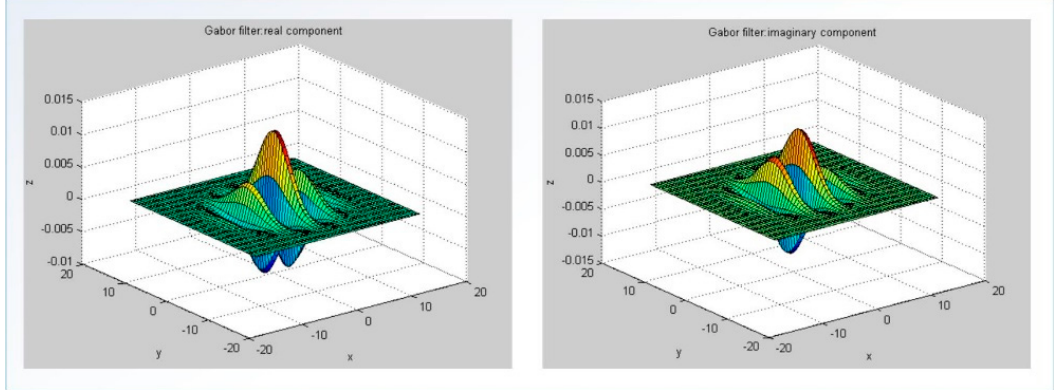
Figure 2. 3D schematic diagram of Gabor filter.